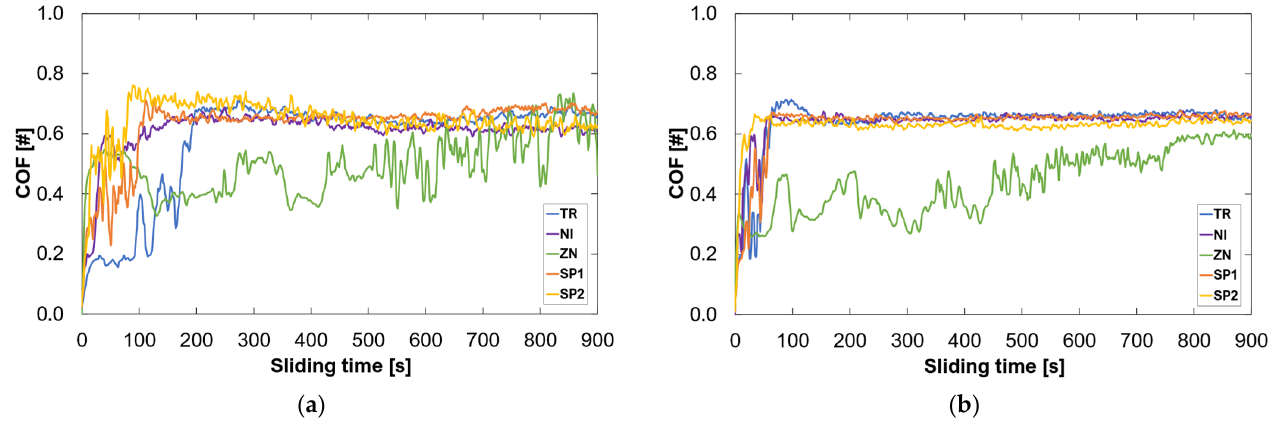
Figure 6. COF evolution during LT tests: ( a ) 1 Hz sliding frequency and ( b ) 2 Hz sliding frequency. Table 5. LT tests summary: frequency (f), transition time ( t tr ) , steady COF ( COF st ) , and COF’s coefficient of variation ( cv COF )